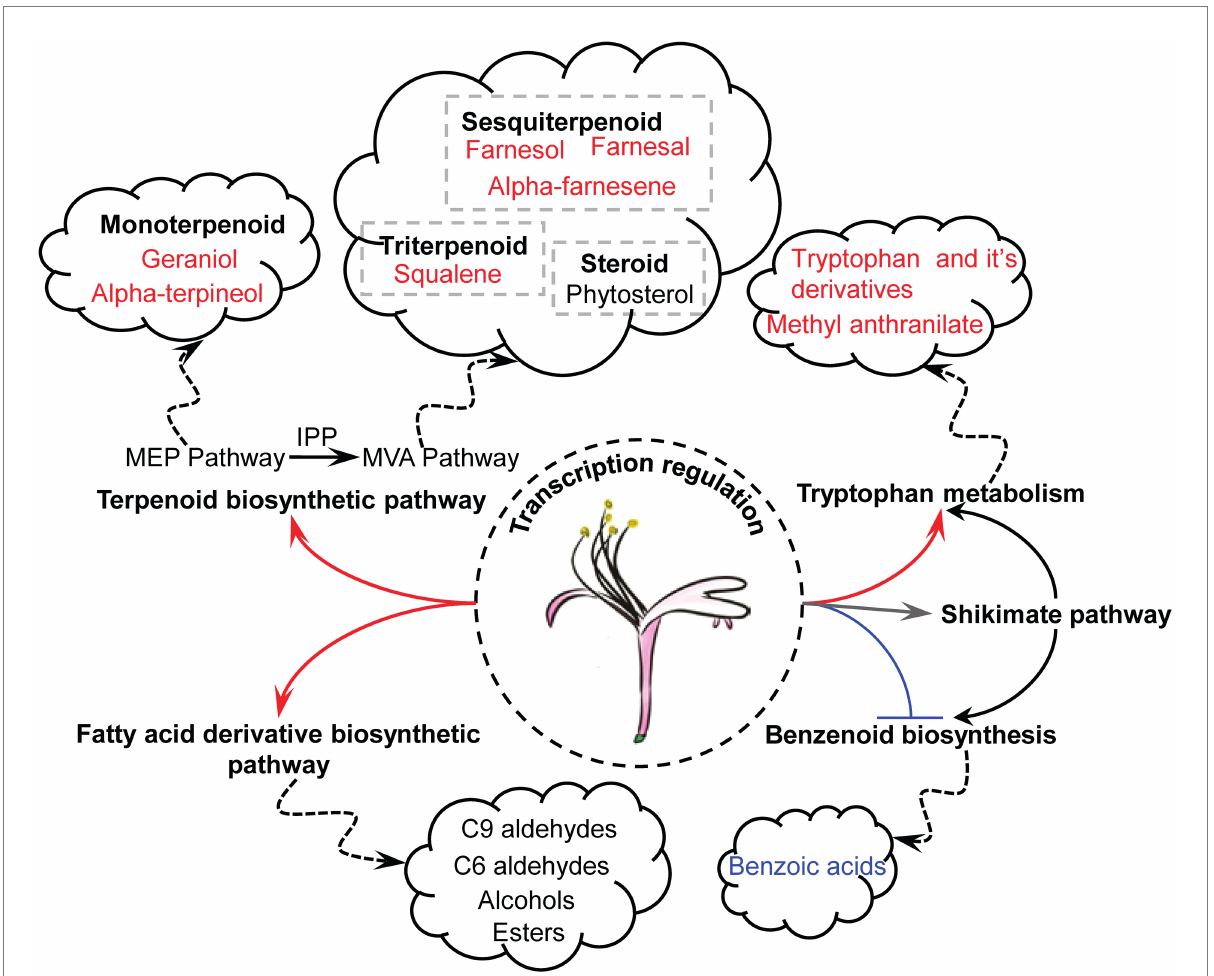
FIGURE 10 Schematic presentation of differentially regulated pathways and VOCs in LJFs of ‘Yujin2’ compared to ‘Fengjin1’. The biosynthetic pathways and accumulations of terpenoids, tryptophan and its derivatives, and fatty acid derivatives were upregulated, while the benzenoid biosynthesis was downregulated in